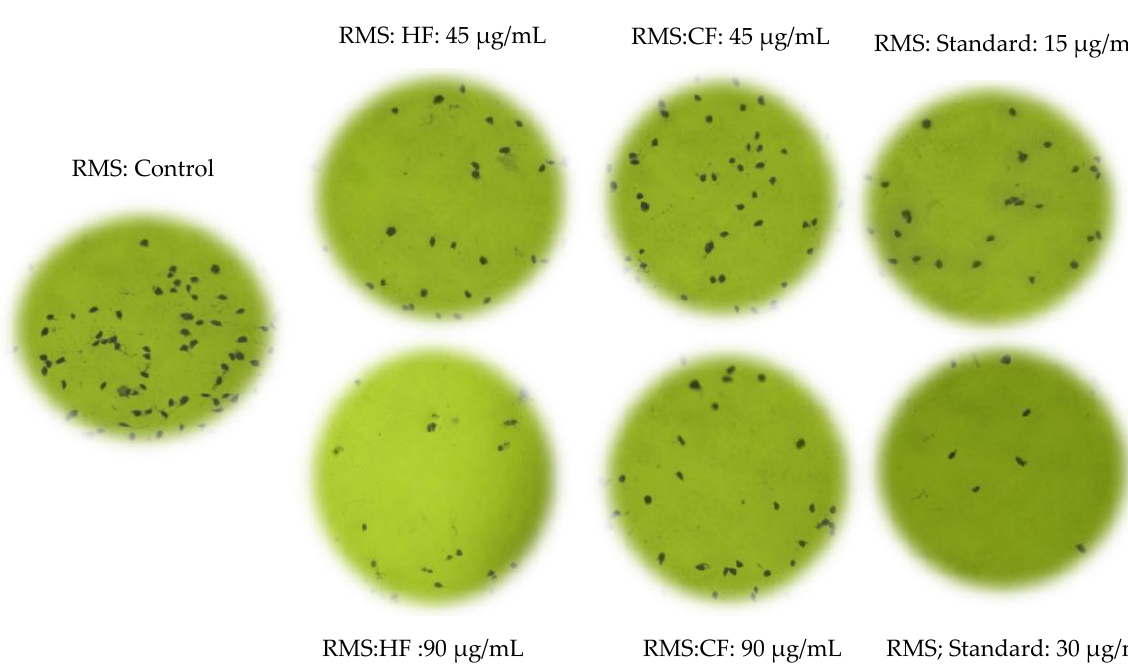
Figure 2. The RMS cells’ colony formation ability, following treatment with the hexane and chloroform fractions at two different concentrations from the standard cycloheximide. HF: hexane fraction; CF: chloroform fraction.